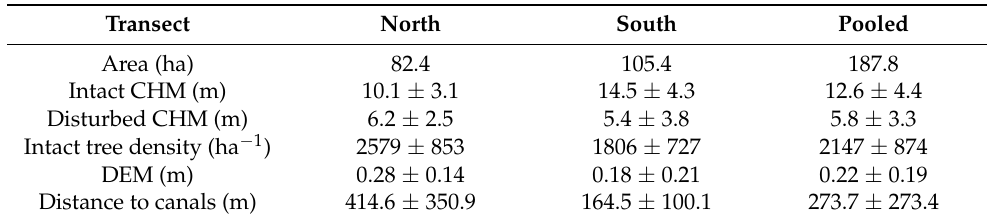
Table 1. Summary of the comparison between the two transects. Numbers were computed based on 5 m resolution maps. We did not attempt to conduct statistical comparisons as these means are based on spatially dependent maps.